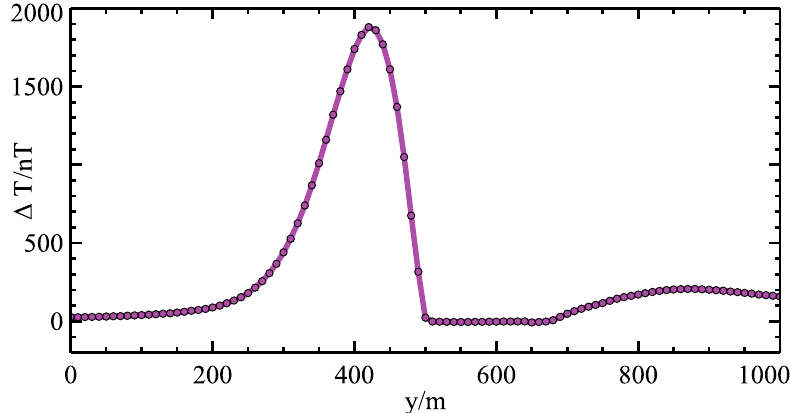
Figure 14. The magnetic contour map of ∆ T in the Zaohuoxi area. (ZK is the borehole position and L is the survey line).